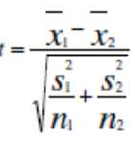
Figure 2. Independent t-test